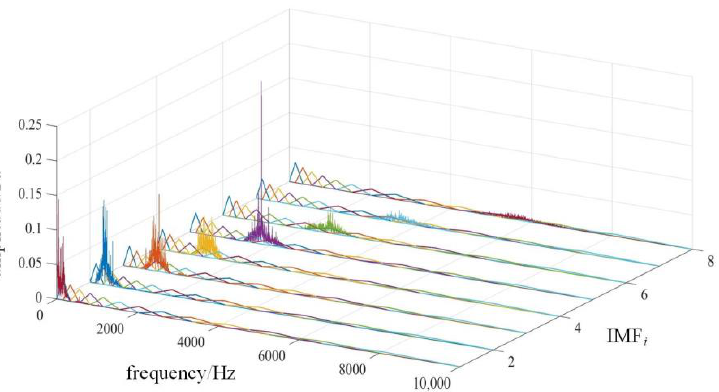
Figure 3. The frequency domain distribution of each IMF component is mapped on the Mel filter bank.